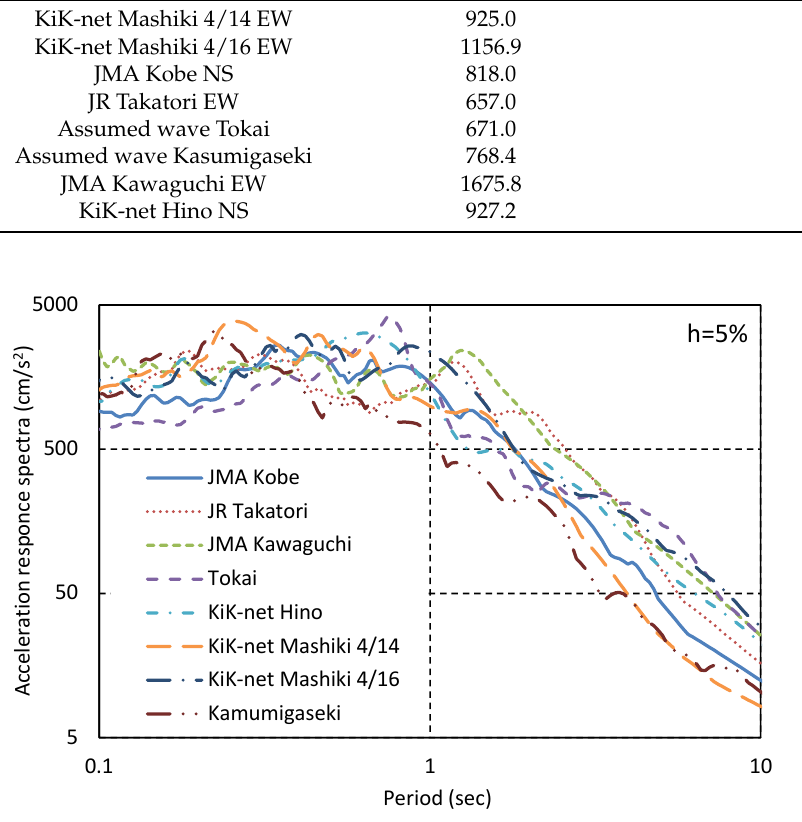
Figure 11. Acceleration response spectra of used ground motion.